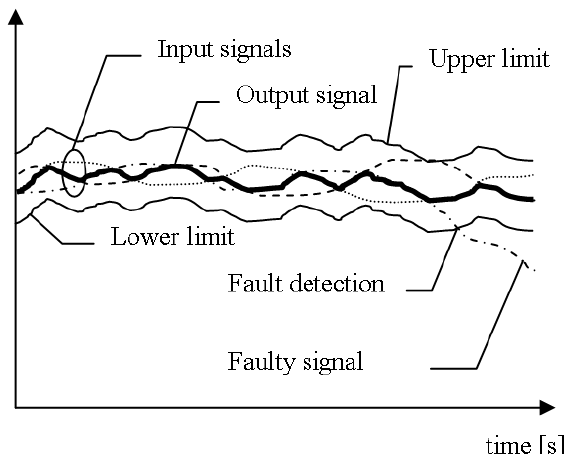
Fig 3. Voting system in